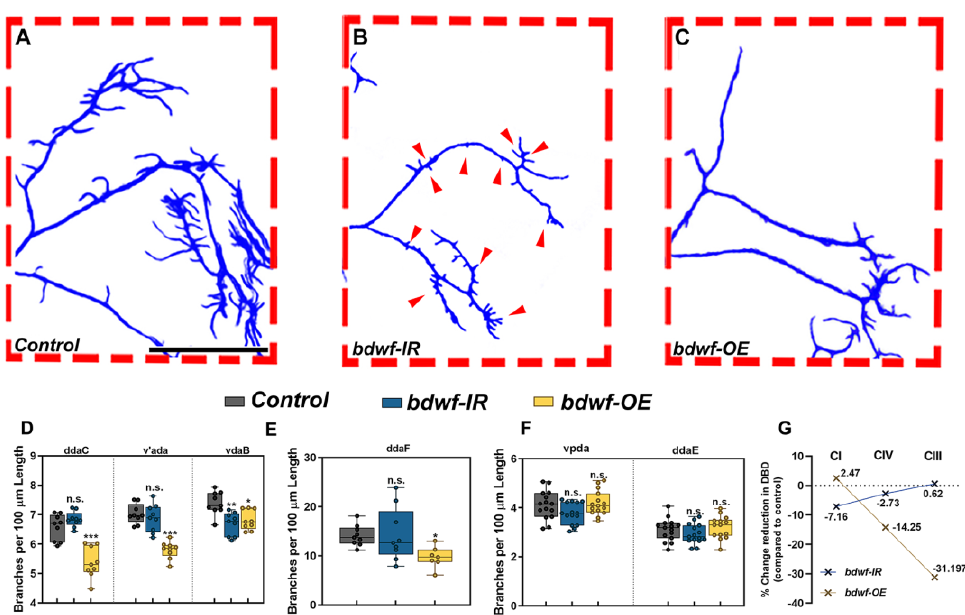
Figure 2. bdwf is required for proportional dendritic growth and branching. ( A – C ) Compared to wild-type ( A ), Bdwf LOF ( B ) results in a proportional reduction of TDB with respect to TDL, as seen by the reduction in the size and number of CIII dendritic termini (red arrows). In contrast, Bdwf GOF ( C ) results in the suppression of dendritic termini. Scale bar, 100 µ m. ( D – F ), Quantification of TDBD for CIV, III, and I neurons ( D – F ), respectively. ( G ) Class-specific effects of Bdwf LOF and GOF on TDBD represented as percentage change from control. * p ≤ 0.05, ** p ≤ 0.01, *** p ≤ 0.001, n.s. = not significant (One-way ANOVA with Dunnett’s multiple comparison test ). n = 14 – 15 for CI, n = 7,9 for CIII and n = 8,9 for CIV. Genotypes: Gal4 ppk , GAL80 ppk , UAS – mCD8::GFP/+; +/+ or